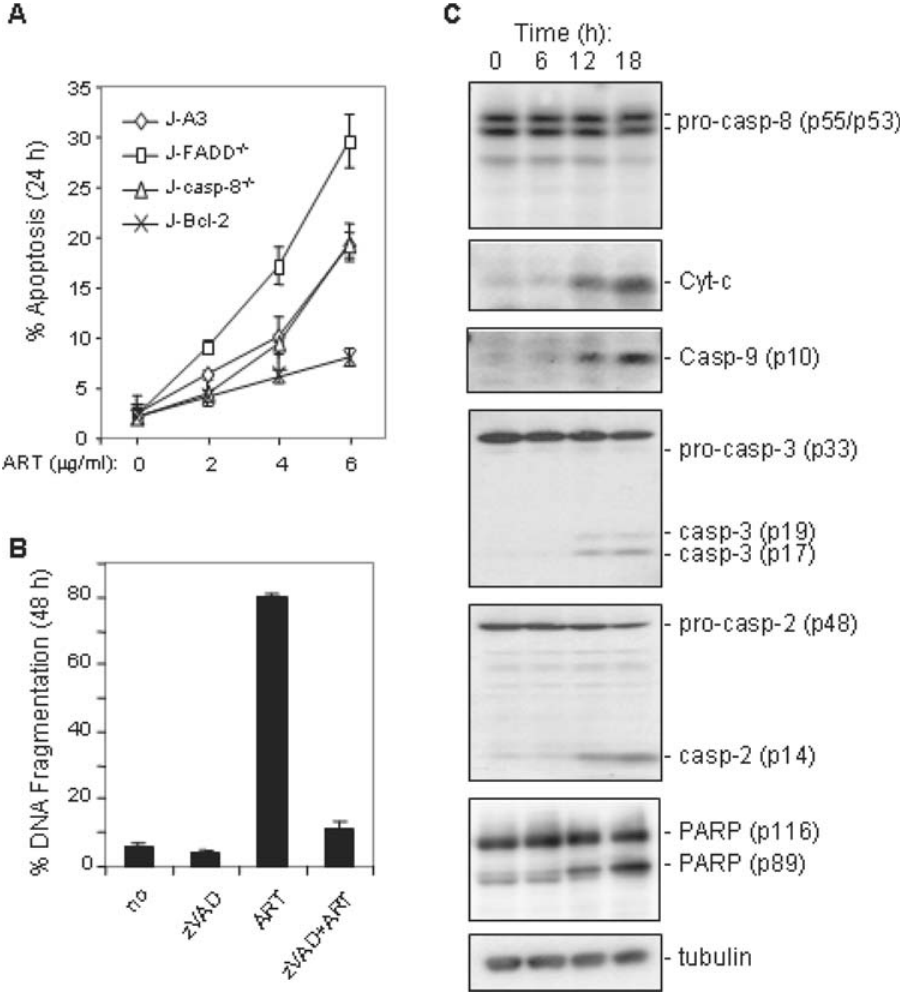
Figure 2. ART induces apoptosis through the intrinsic (mitochondria) pathway. (A) The death receptor system is not required for ART-induced apoptosis. Jurkat cells deficient in FADD (FADD 2 / 2 ), caspas-8 (casp-8 2 / 2 ), or over-expressing Bcl-2 and parental (A3) Jurkat cells were treated with different does of ART. Apoptotic cell death was determined by FSC/SSC in triplicates. (B) ART-induced apoptosis involves caspases. Jurkat cells were treated with ART (4 m g/ml) in the presence or absence of 50 m M of pan-caspase inhibitor zVAD-fmk for 48 h. Apoptotic cell death was determined by DNA fragmentation in triplicates. (C) ART induces cytochrome c release and activation of caspase-2, 3 and 9. CEM leukemia cells were treated with 1 m g/ml ART for different times as indicated. Cell lysates were subjected to Western blotting with antibodies against cytochrome c, caspase-2, 3, 8, 9, PARP, and control antibodies against tubulin. Data are representative of three independent experiments.